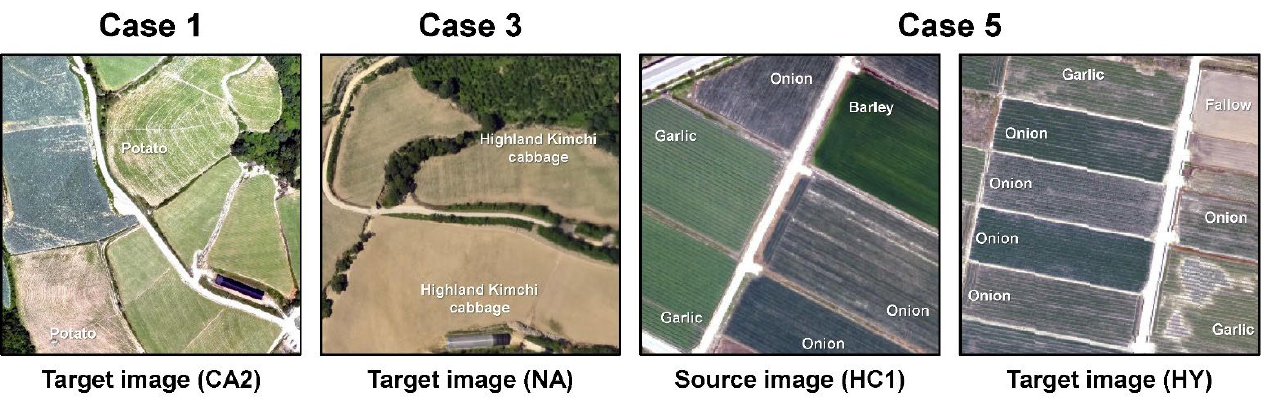
Figure 9. An illustration of the difference in sowing times in the target domain (cases 1 and 3) and growth status between the source and target domains (case 5). The crop type per parcel is shown in white.